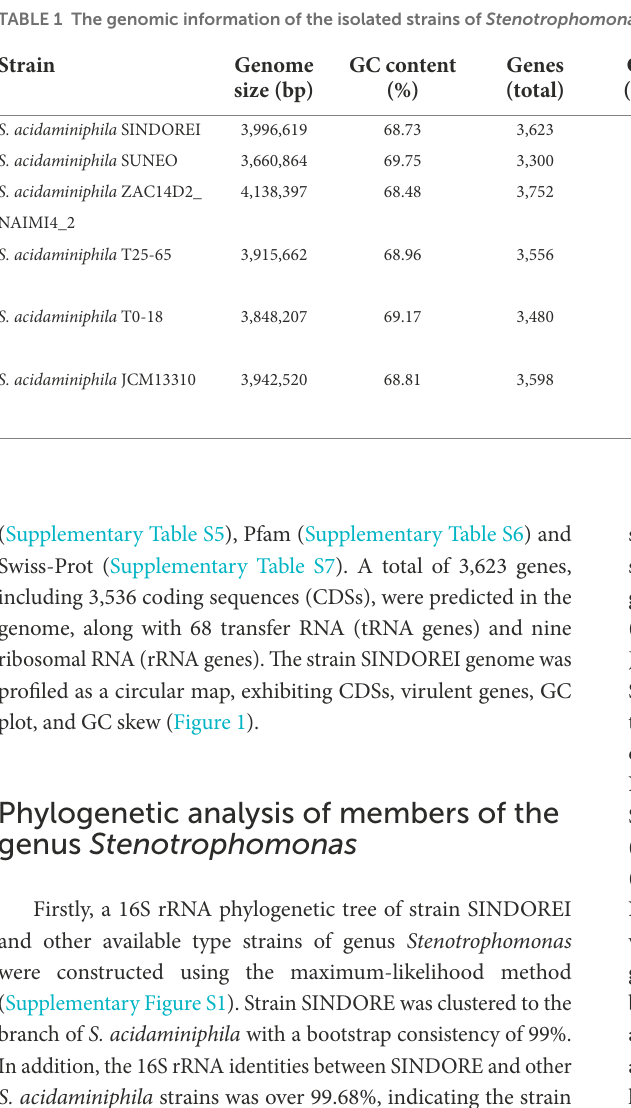
TABLE 1 The genomic information of the isolated strains of Stenotrophomonas acidaminiphila.